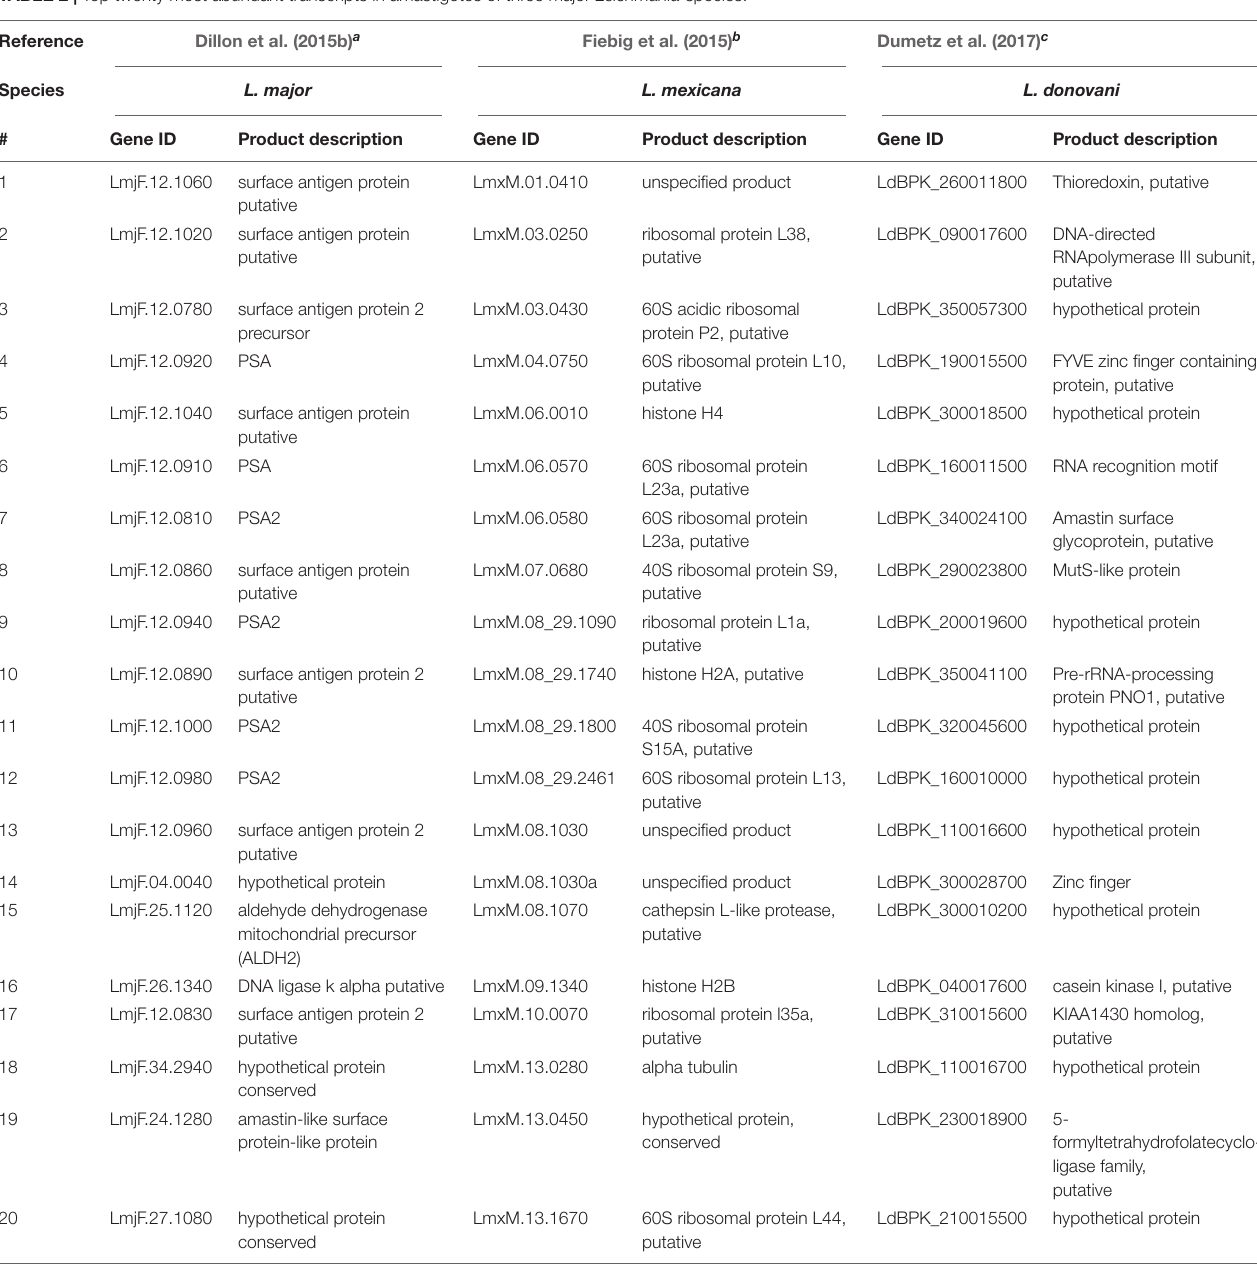
TABLE 2 | Top twenty most abundant transcripts in amastigotes of three major Leishmania